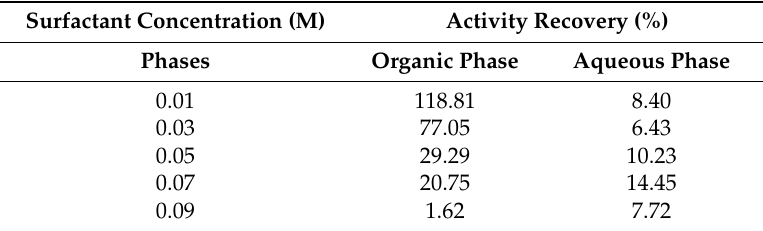
Table 2. Effect of the surfactant concentration on the forward extraction (organic phase) and the backward extraction (aqueous phase) in the Triton X-100/toluene reverse